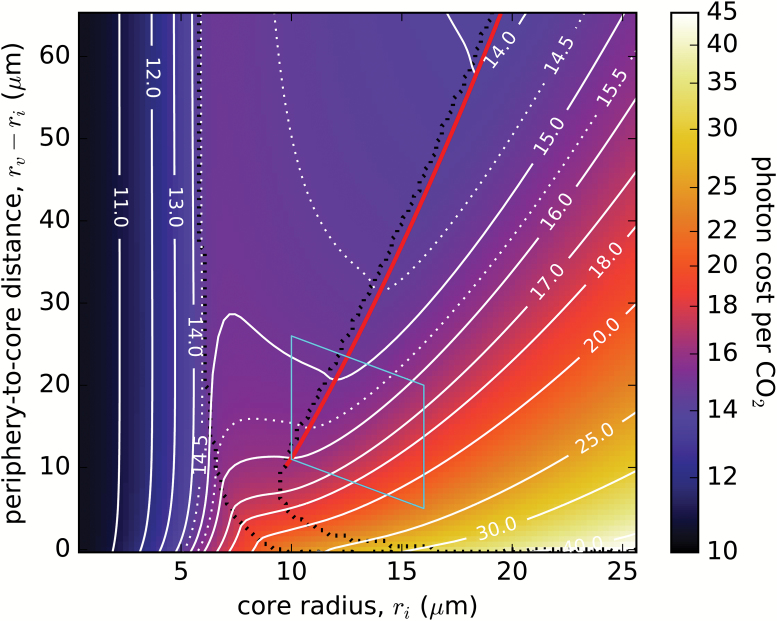
C4-optimized photon cost as a function of the core radius, ri, and the periphery to core distance, rv–ri. The lines of constant photon cost are in white. The red line traces the local minima (in ri) of the C4-optimized photon cost. Dashed black lines mark boundaries between regions where the optimum cost is found at zero, finite, and abundant PEPC concentration (compare Fig. 2a, also see the main text). The light-blue parallelogram shows the measured range of a mature Bienertia cell and CCC sizes (from Akhani et al., 2005, 2012). Parameters are as in Fig. 2.